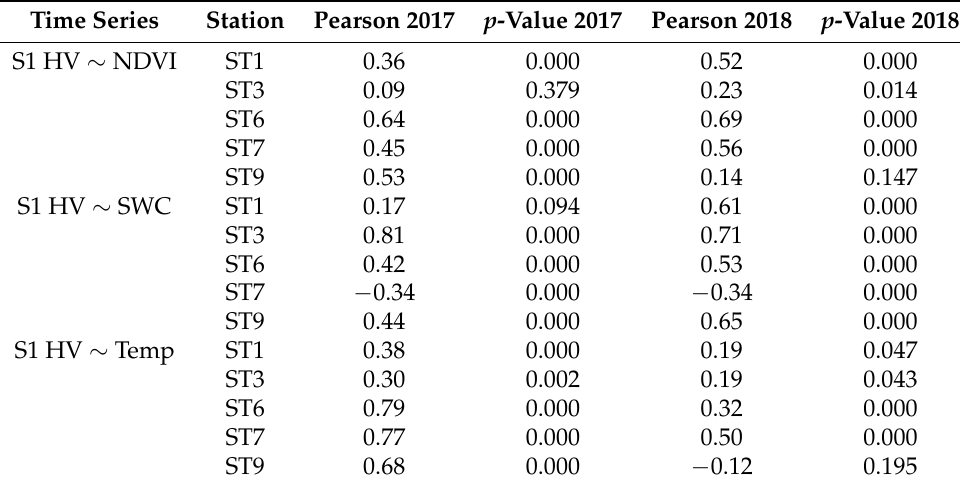
Table 4. Pearson correlation coefficient ( R ) and p -value for the five stations.